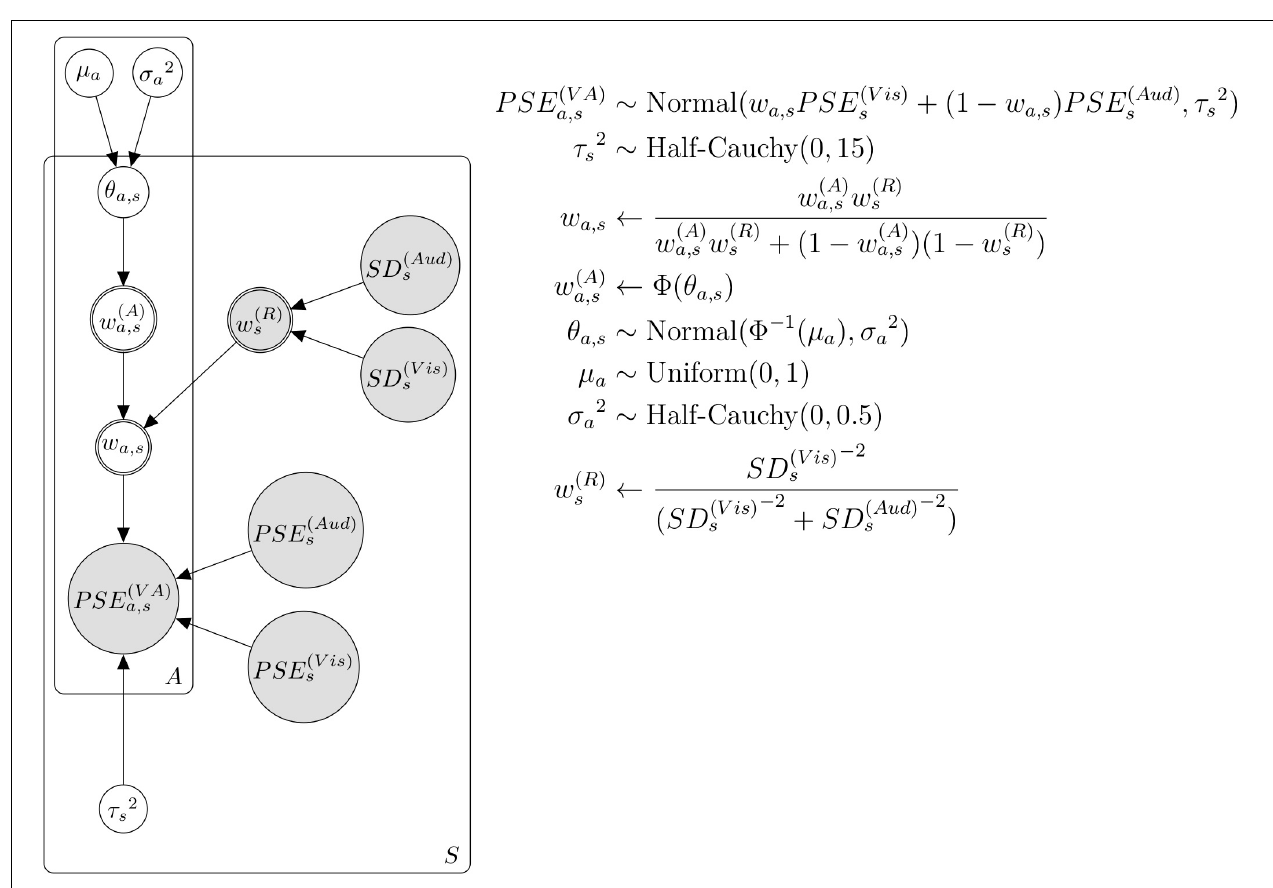
FIGURE 4 | Bayesian hierarchical model with the weights by attention and reliability. A and a represent each attention condition. S and s represent each